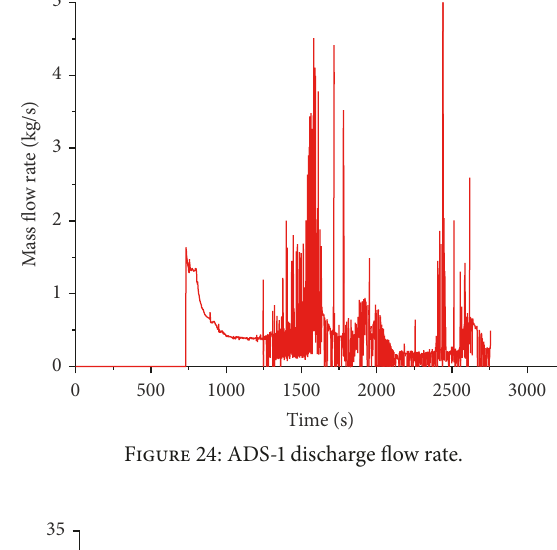
Figure 27: ADS-4A discharge flow